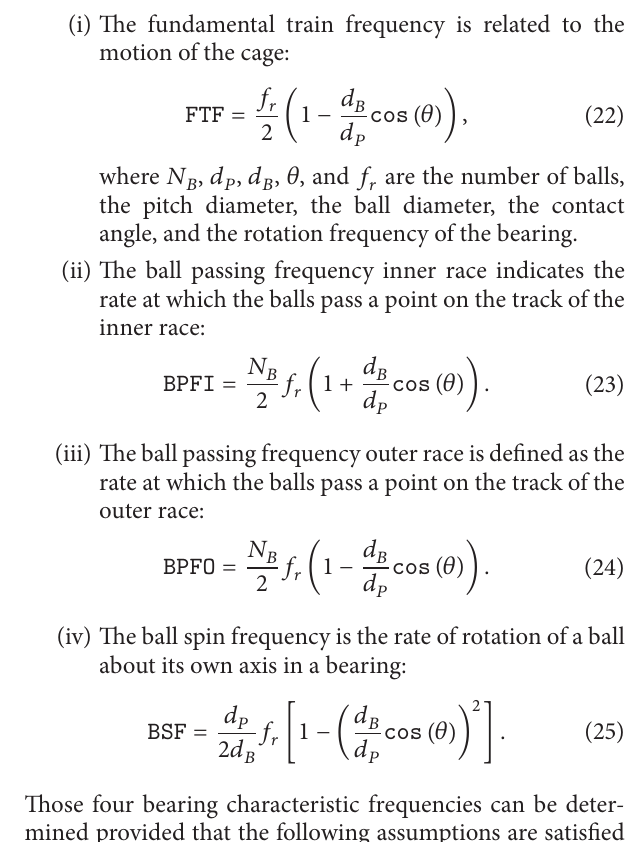
Figure 1: Schematic representation of a roller bearing.